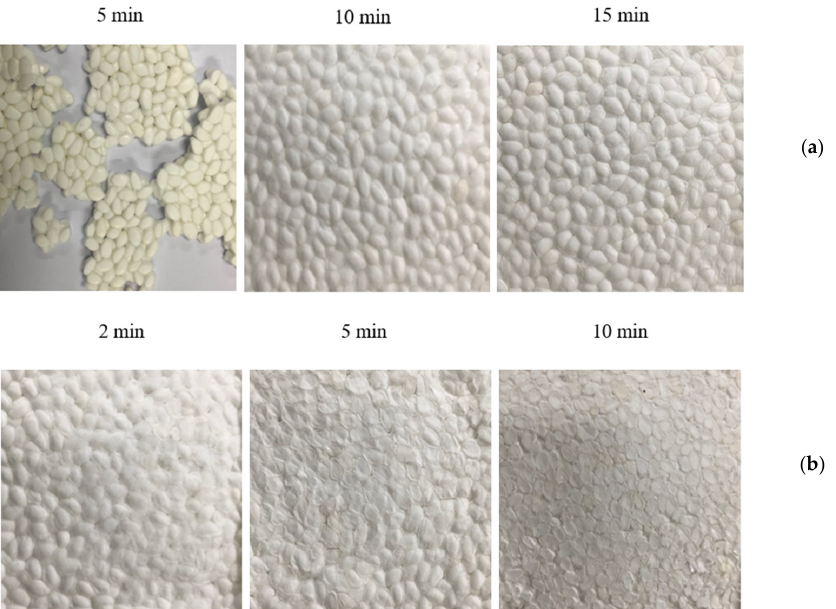
Figure 5. Effect of molding time in the compression molding of ETPU beads at 3.5 MPa, molding temperature: ( a ) 145 °C; ( b ) 150 °C.